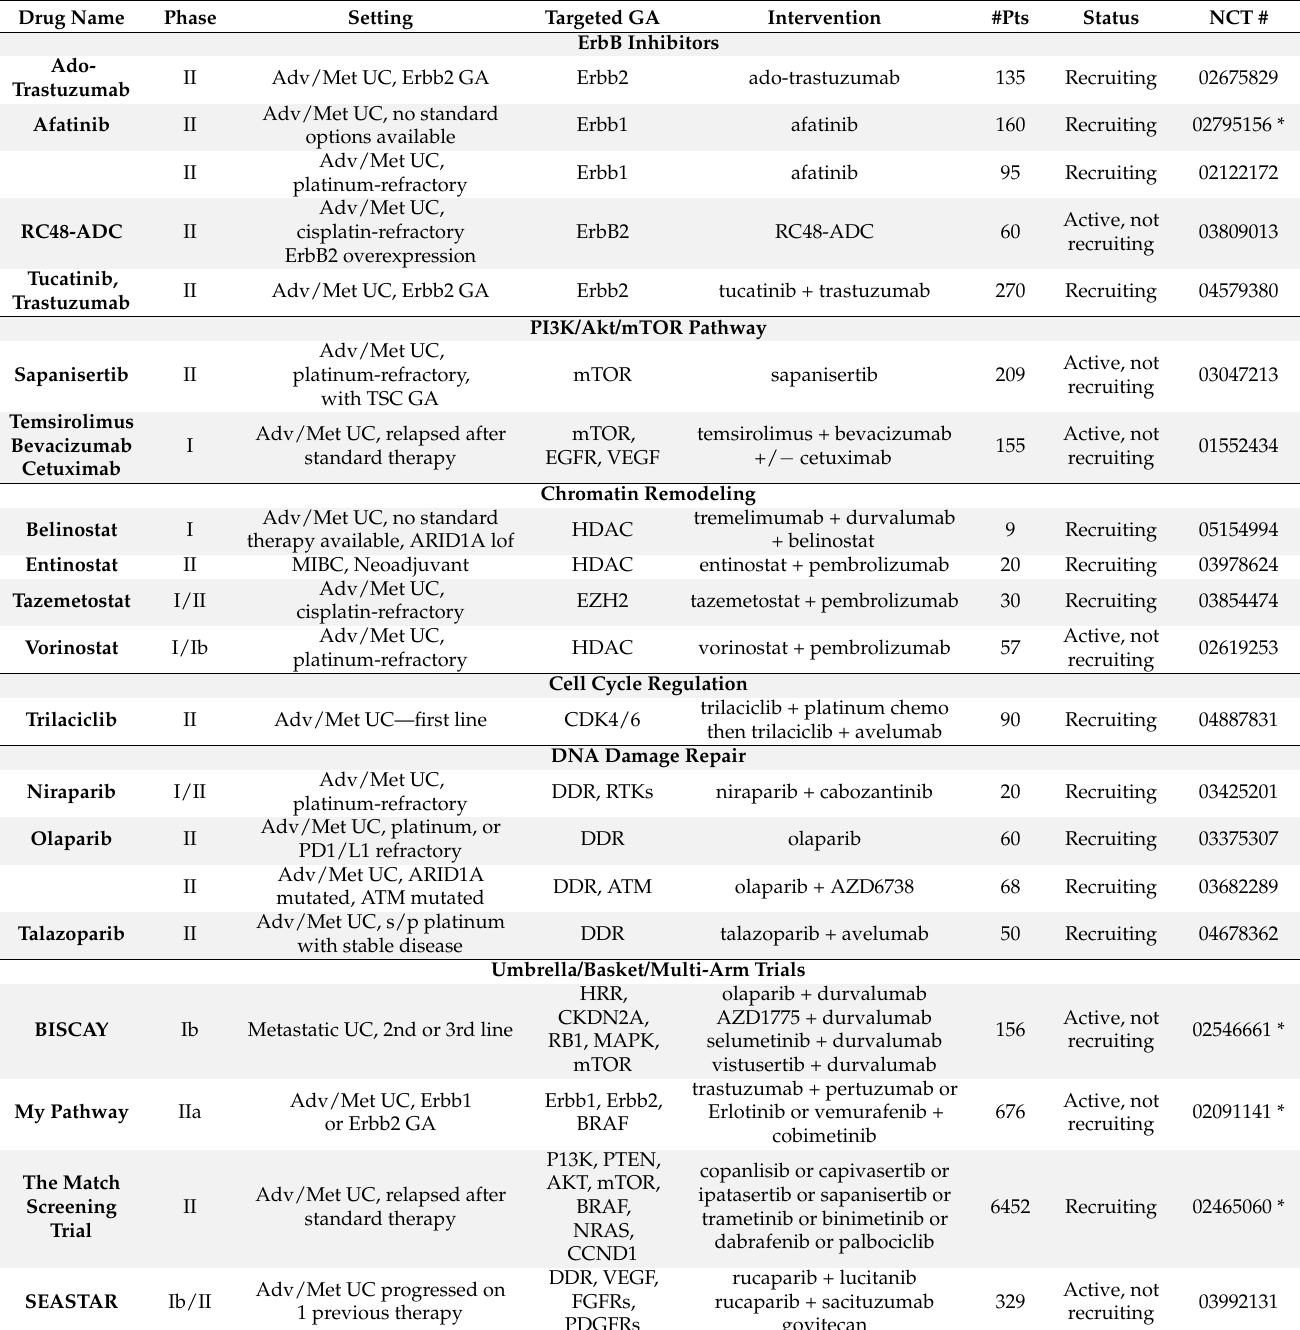
Table 2. Ongoing clinical trials targeting genetic alterations in advanced bladder cancer (not including